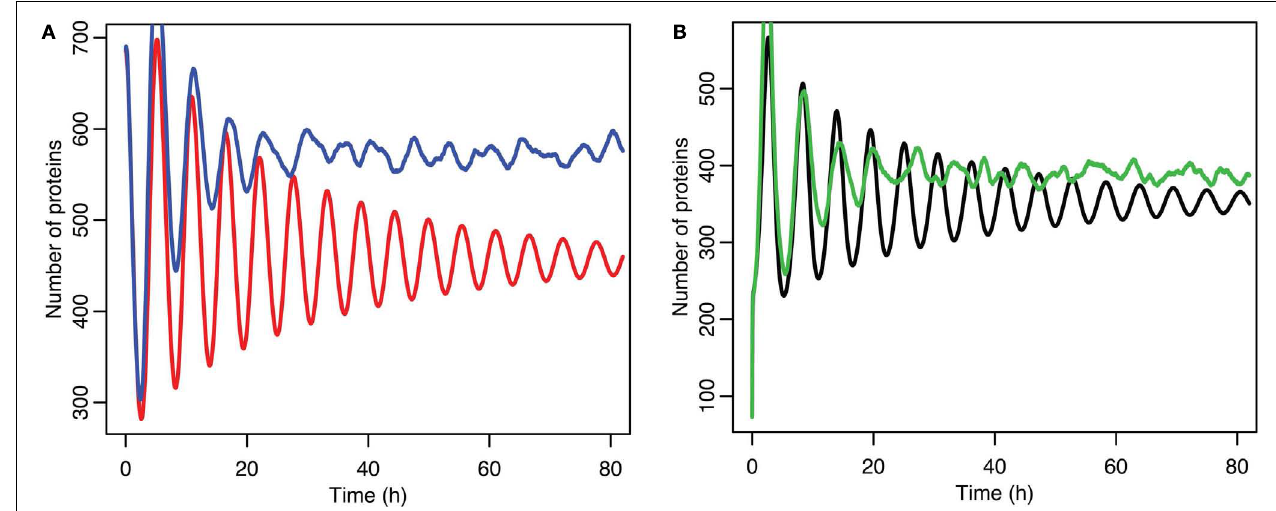
and from the mean of 5,000 runs of the stochastic model in blue. (B) Shows the comparison for p53 with the deterministic model in black and from the mean of 5,000 runs of the stochastic model in green.